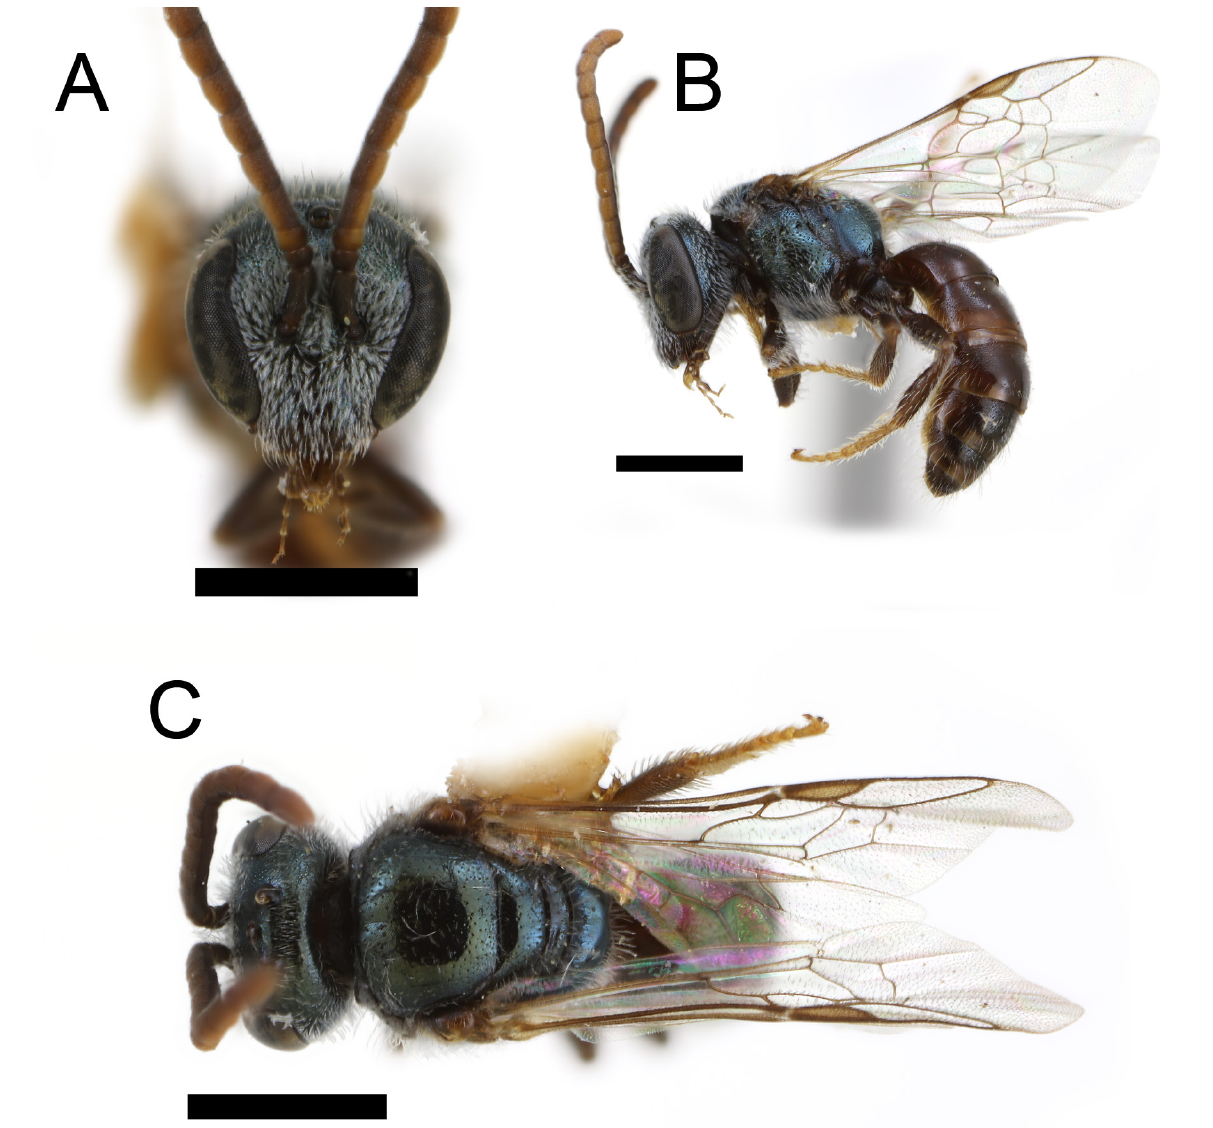
Fig. 7. Lasioglossum amona sp. nov., ♂. A . Face. B . Lateral habitus. C . Dorsal habitus. Scale bars = 1